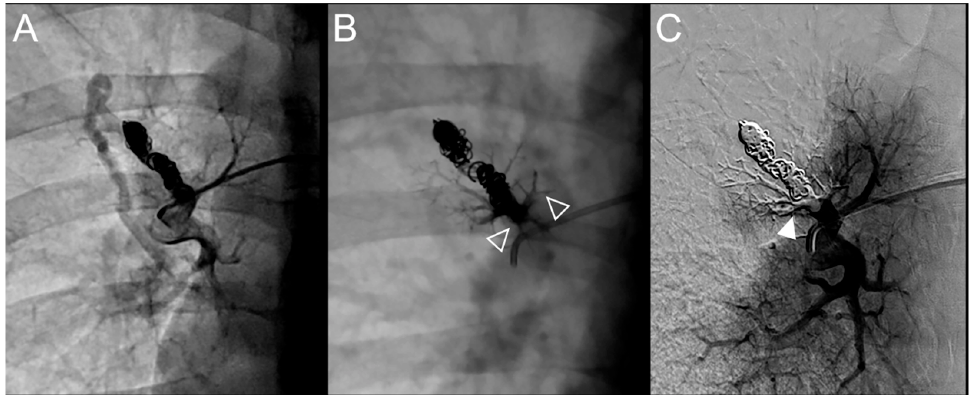
Figure 6. Case example of a 35-year-old man treated for a recurrent simple pulmonary arteriovenous malformation in the right lower lobe. The pulmonary angiograph showed a distance between the last coil and a healthy arterial branch too short to add additional coils. Embolization was thus performed